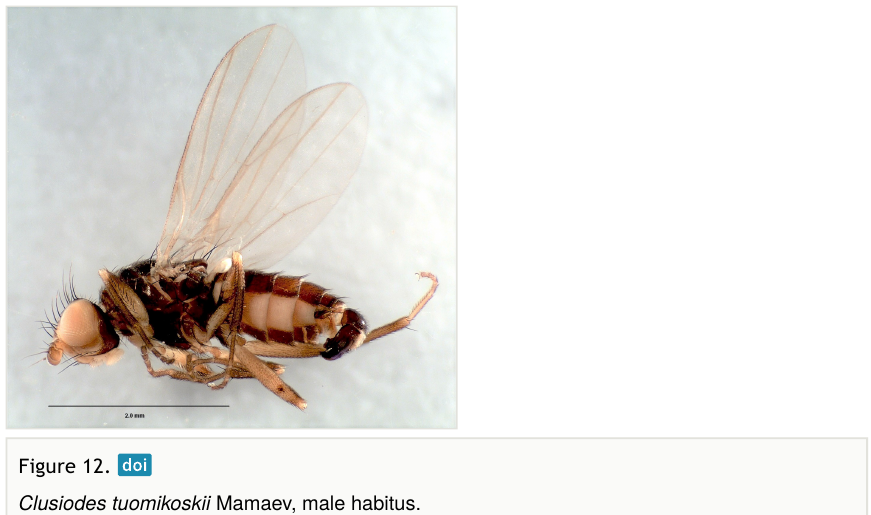
Figure 12. Clusiodes tuomikoskii Mamaev, male